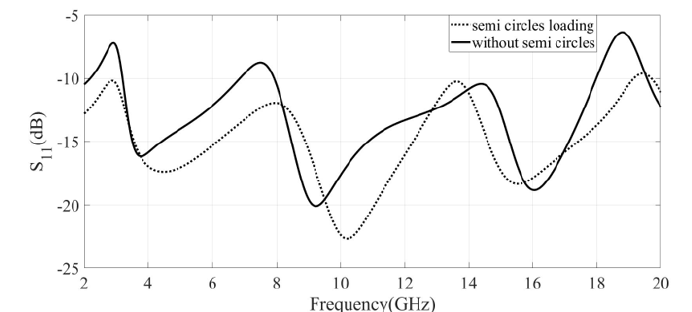
Figure 2. S 11 parameter with and without the loading of semi-circles to show the impedance matching improvement for semi-circle loading. The inclusion of a smooth curve or bevel shape technique is used to improve impedance matching.